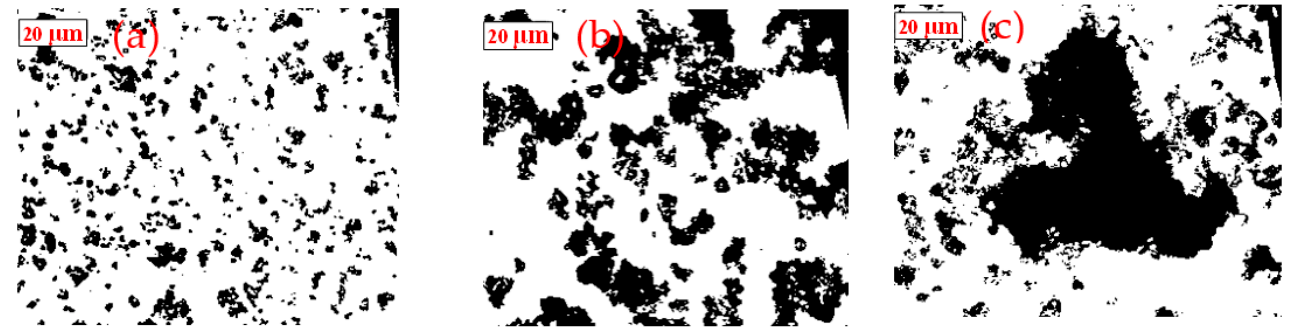
Figure 5. Optical microscope images of scheelite in the presence of BHA ( a ) and NaOL after stirring at 900 r/min for 10 min ( b ) and 1300 r/min for 20 min ( c ).